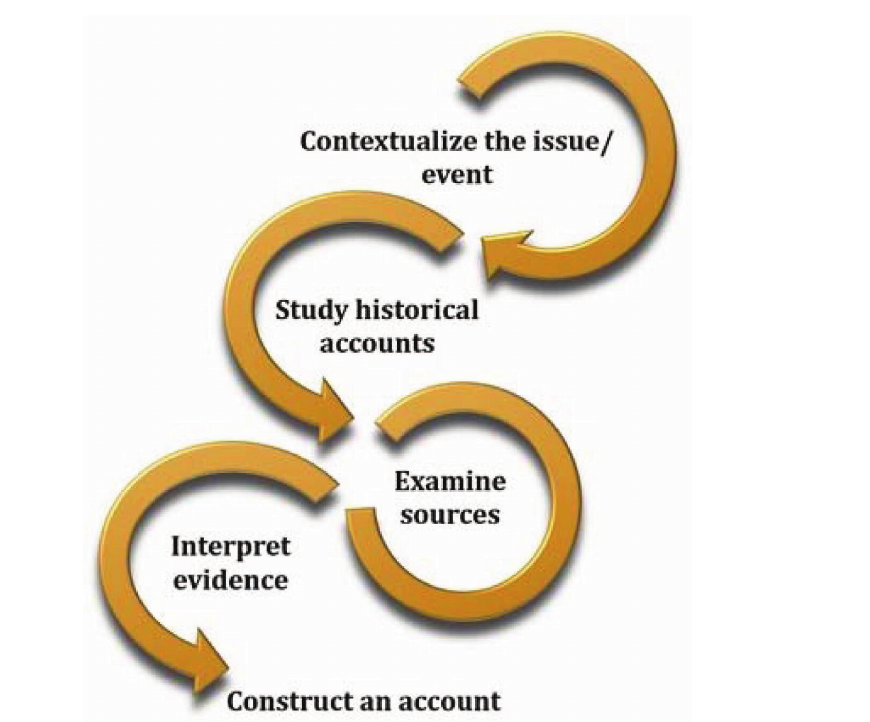
Figure 1: Approaching a historical